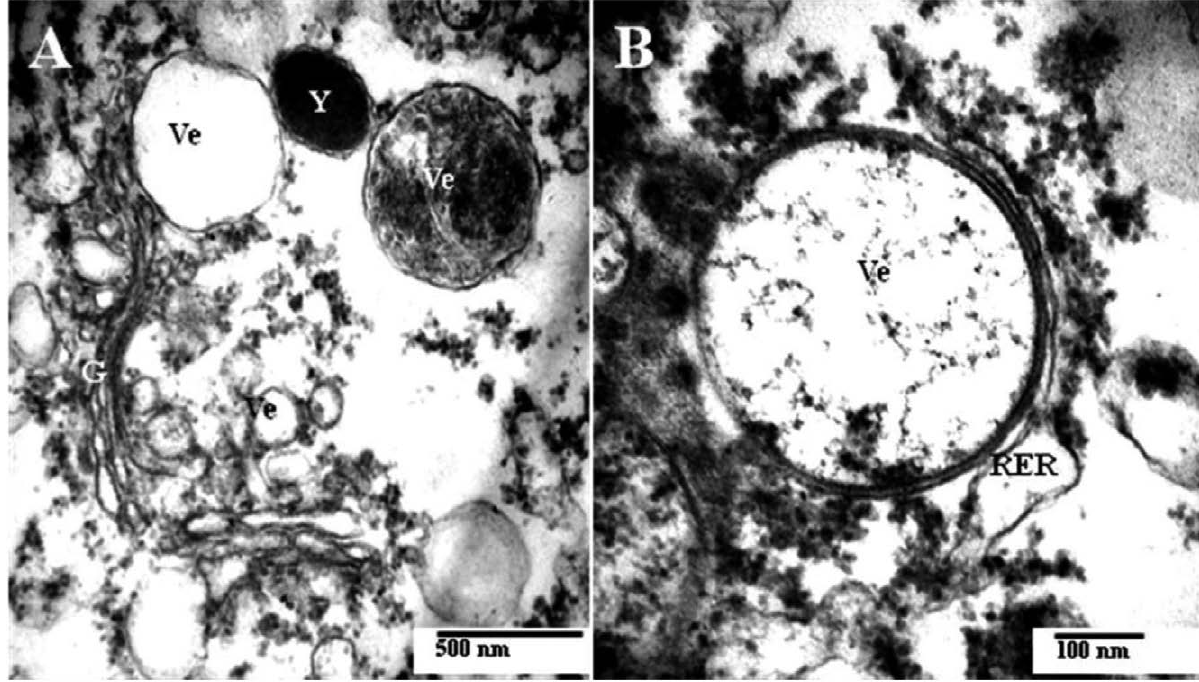
Fig. 6. – A, TEM of a previtellogenic oocyte III; vesicles deriving from the Golgi complex are visible. B, rough endoplasmic reticulum (RER) in close contact with Golgi vesicles